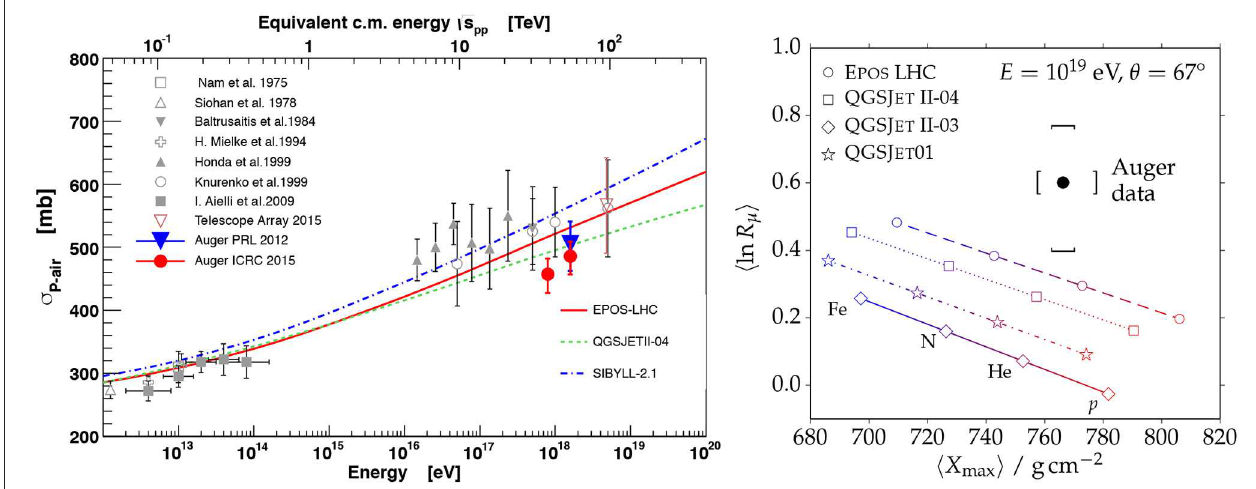
FIGURE 7 | Left: Compilation of proton-air cross section measurements. See Ulrich et al. (2009) for references. Recent results are the Auger and TA measurements (Abreu et al., 2012; Abbasi et al., 2015; Ulrich, 2016). Reproduced with permission from Ulrich (2016). Right: Correlation between the muon density and the depth of shower maximum in inclined air showers. Here R µ is the muon number relative to the prediction of QGSjet II.03 for proton primaries. Reproduced with permission from Aab et al.